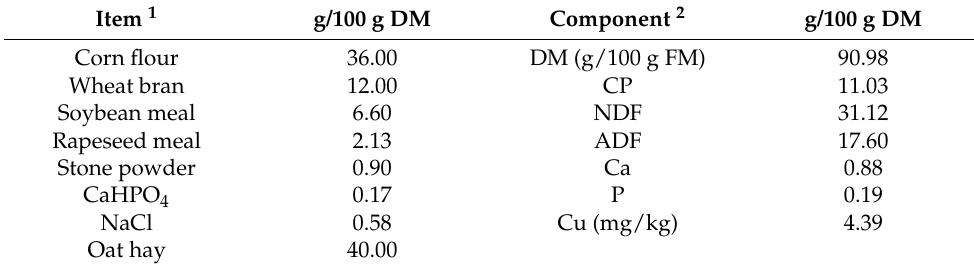
Table 1. Composition and nutrient levels of diet/substrate (dry matter